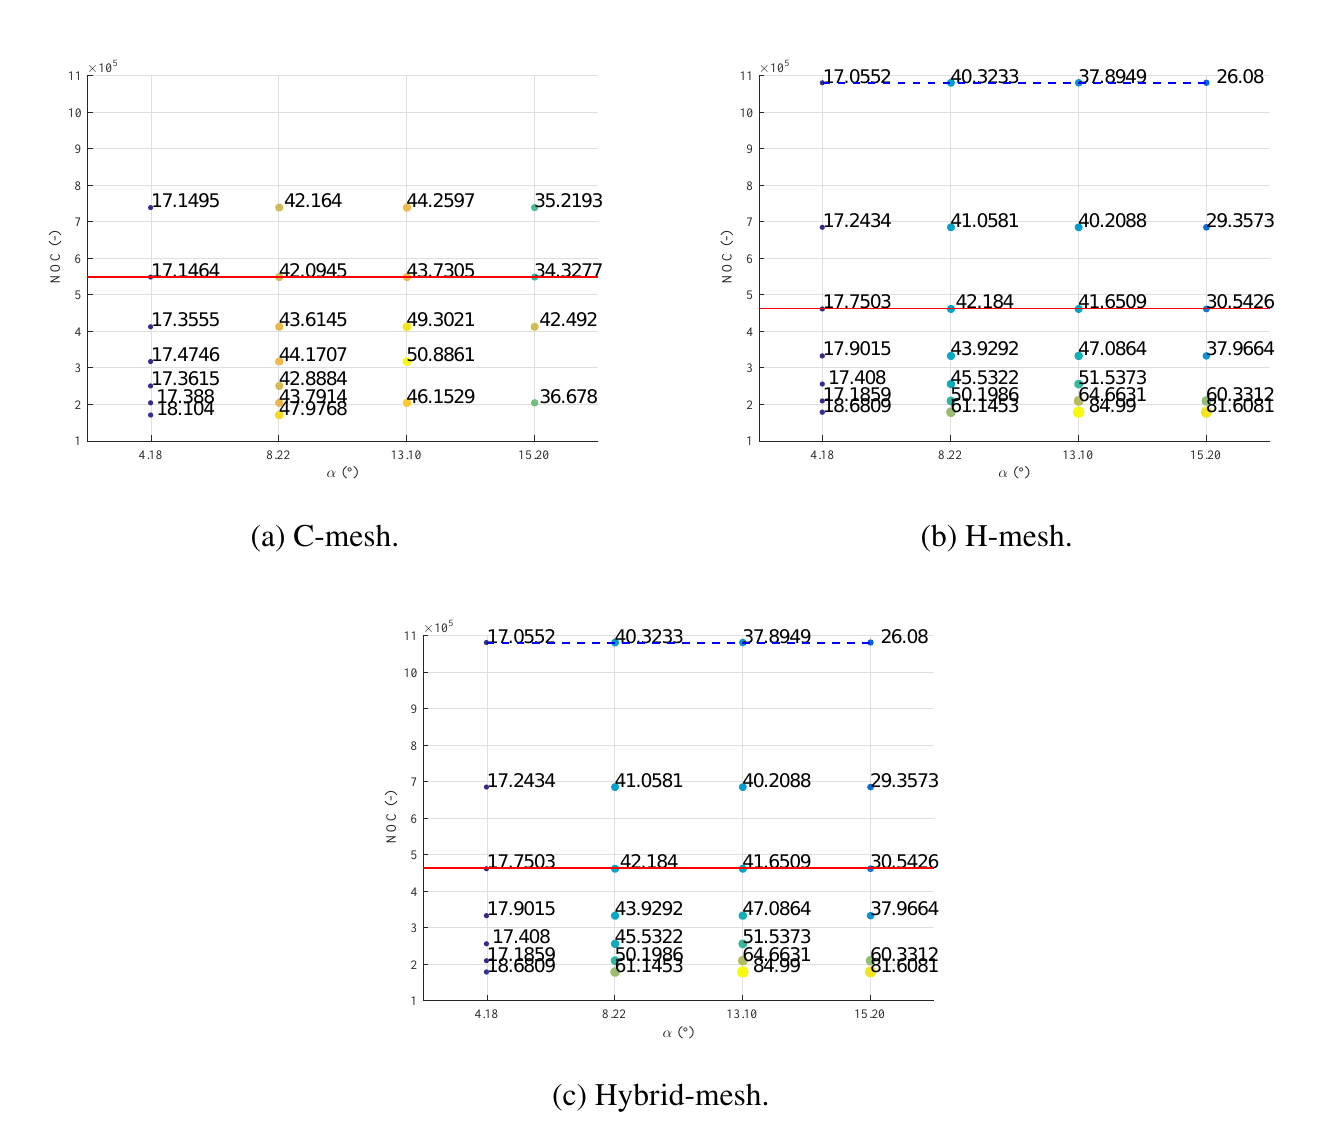
Figure 18. Calculation deviations of C D compared with experimental benchmark data adopted from [25] varying with numbers of cells, while changing chord-wise spacings in the near-field (blue dotted lines connect minimum errors under each α and red lines mark selected mesh settings for each